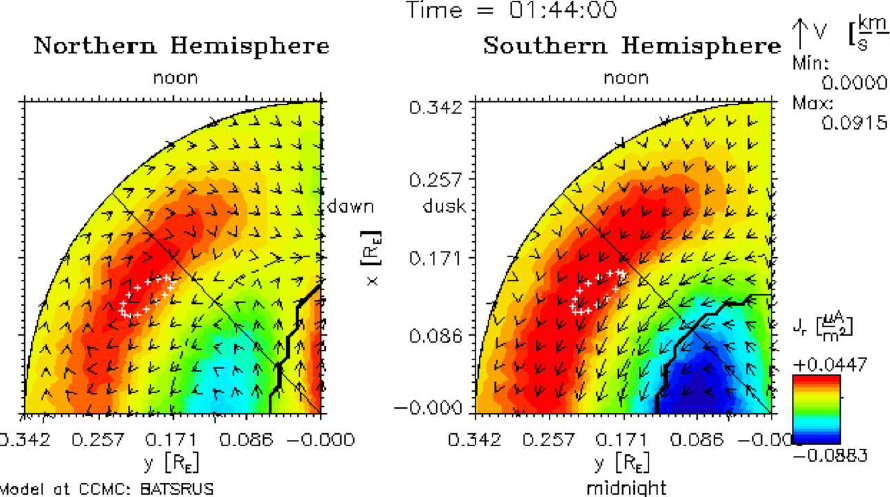
Fig. 14. Northern and Southern Hemispheres of the ionosphere at 01:44UT. The color represents the radial component of the current and the arrows the flow direction. The solid black line marks the boundary of the region with open field lines near the magnetic poles, and the white crosses mark the location where the vortex maps into the ionosphere at about 75 degrees latitude between 12:00 and 18:00LT. A vortex is actually present in the Northern Hemisphere ionosphere, but not in the Southern Hemisphere